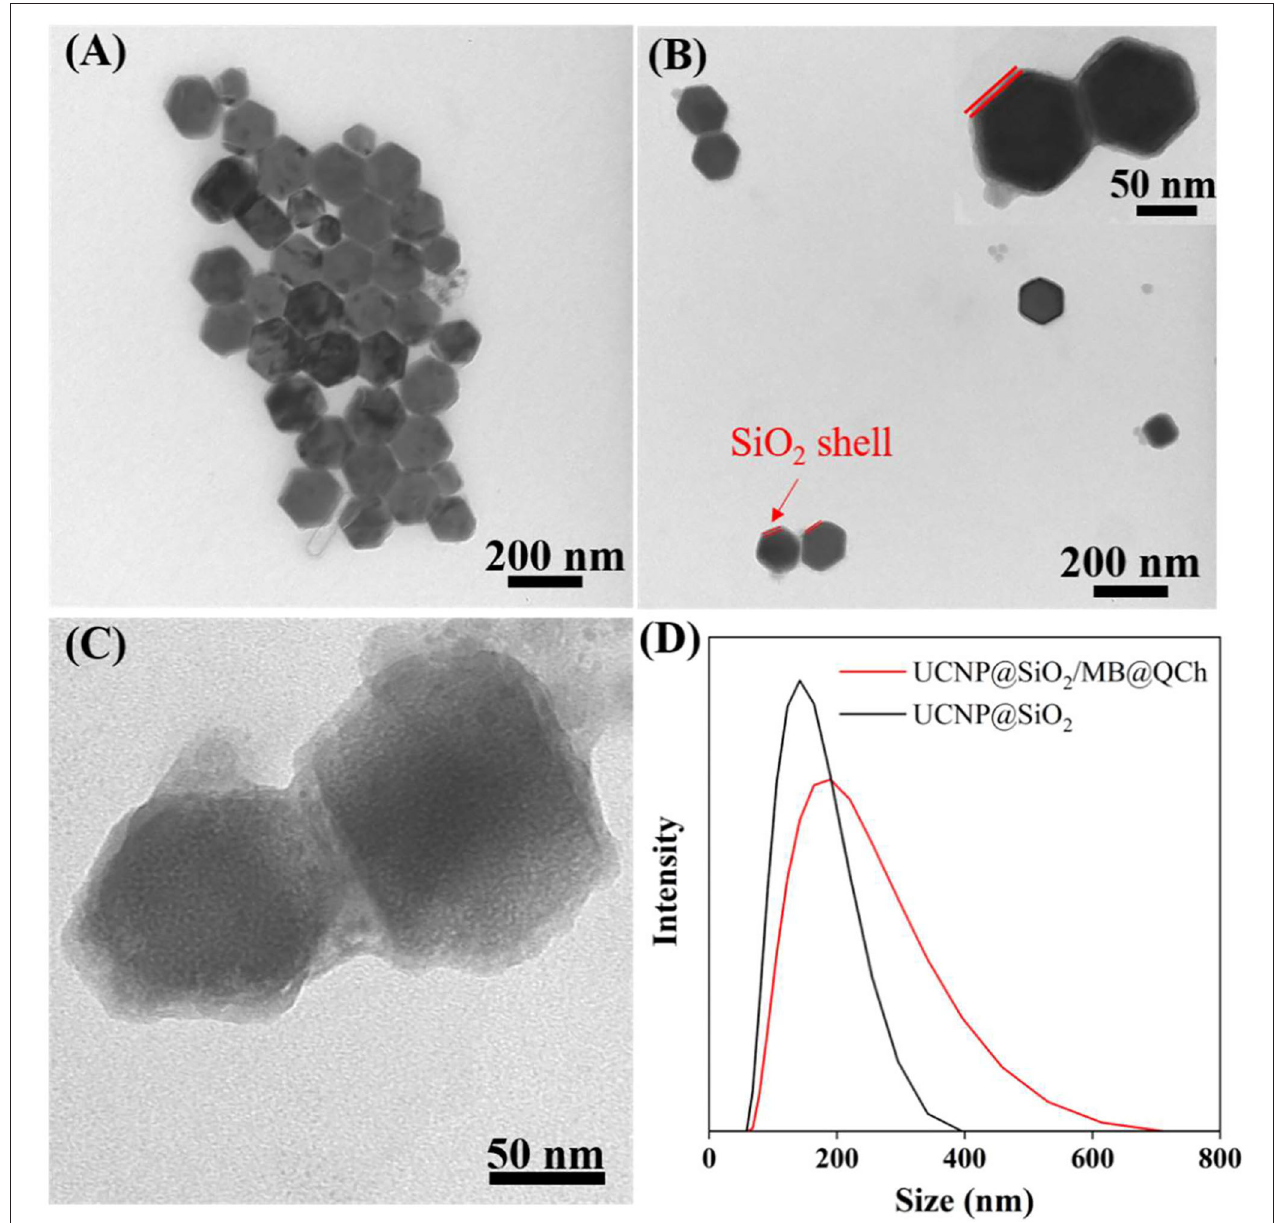
FIGURE 1 | TEM images of (A) UCNP, (B) UCNP@SiO 2 , and (C) UCNP@SiO 2 /MB@QCh. (D) Diameter distributions of UCNP@SiO 2 and UCNP@SiO 2